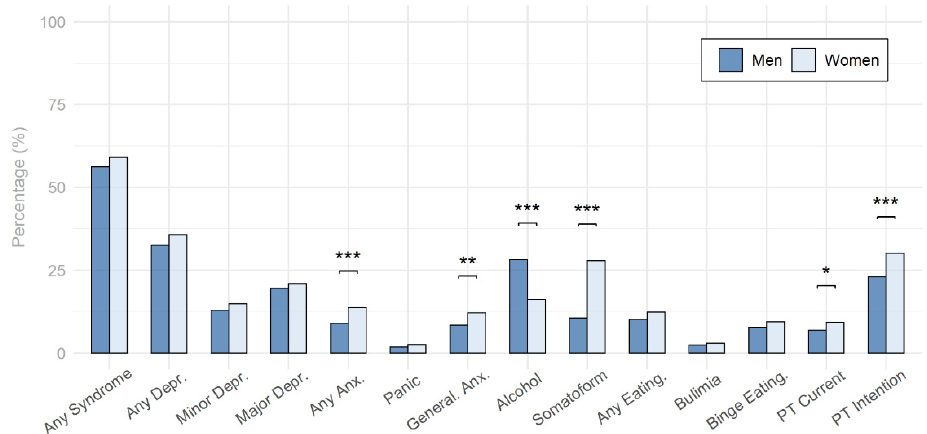
Figure 2. Gender Differences Regarding Screened Psychological Syndromes and Psychotherapy Use. Note. Depr. = Depression, Anx. = Anxiety, General. = Generalized, Eating. = Eating disorder, PT = Psychotherapy. p -values were adjusted for multiple testing using the Holm–Bonferroni